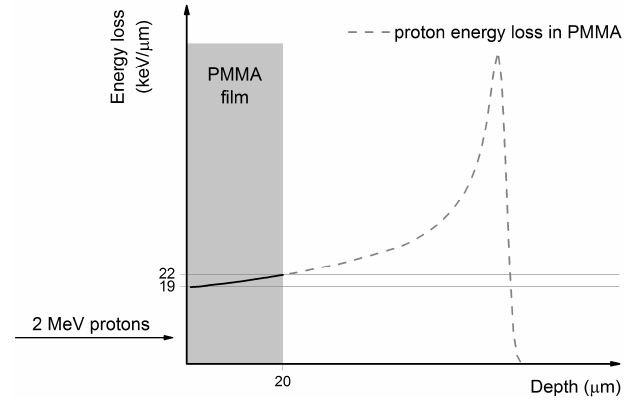
Fig. 2. Linear Energy Transfer of 2 MeV protons in PMMA. The solid line shows the protons